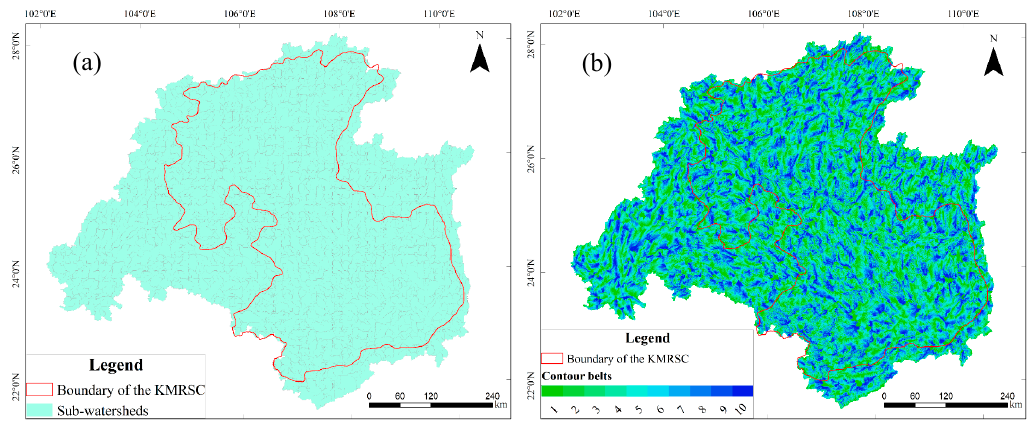
Figure 5. Computation unit in the simulated model domain: ( a ) sub-watersheds and ( b ) contour belts.